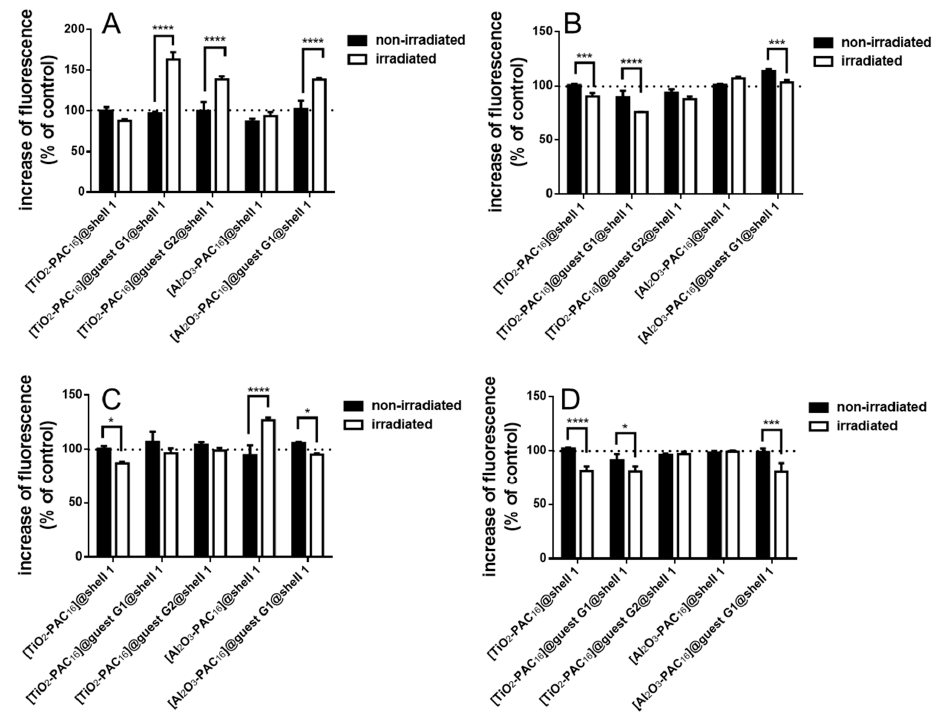
Figure 7. Changes of the ROS level in MCF-7 ( A ) and MCF-10 A cells ( C ) and the superoxide level in MCF-7 ( B ) and MCF-10 A ( D ) cells before and after irradiation with a single dose of 1 Gy, n = 6, *: p < 0.05, ***: p < 0.001, ****: p <